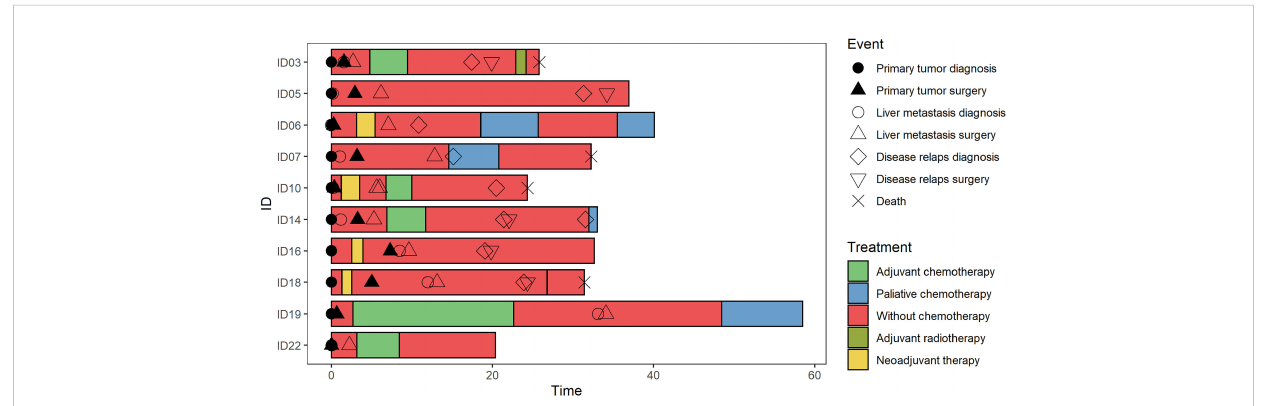
FIGURE 1 Swimmer plot. The clinical and pathological characteristics of 10 patients included in the study. Each bar represents one subject in the study, and symbols along each bar represent various relevant clinical